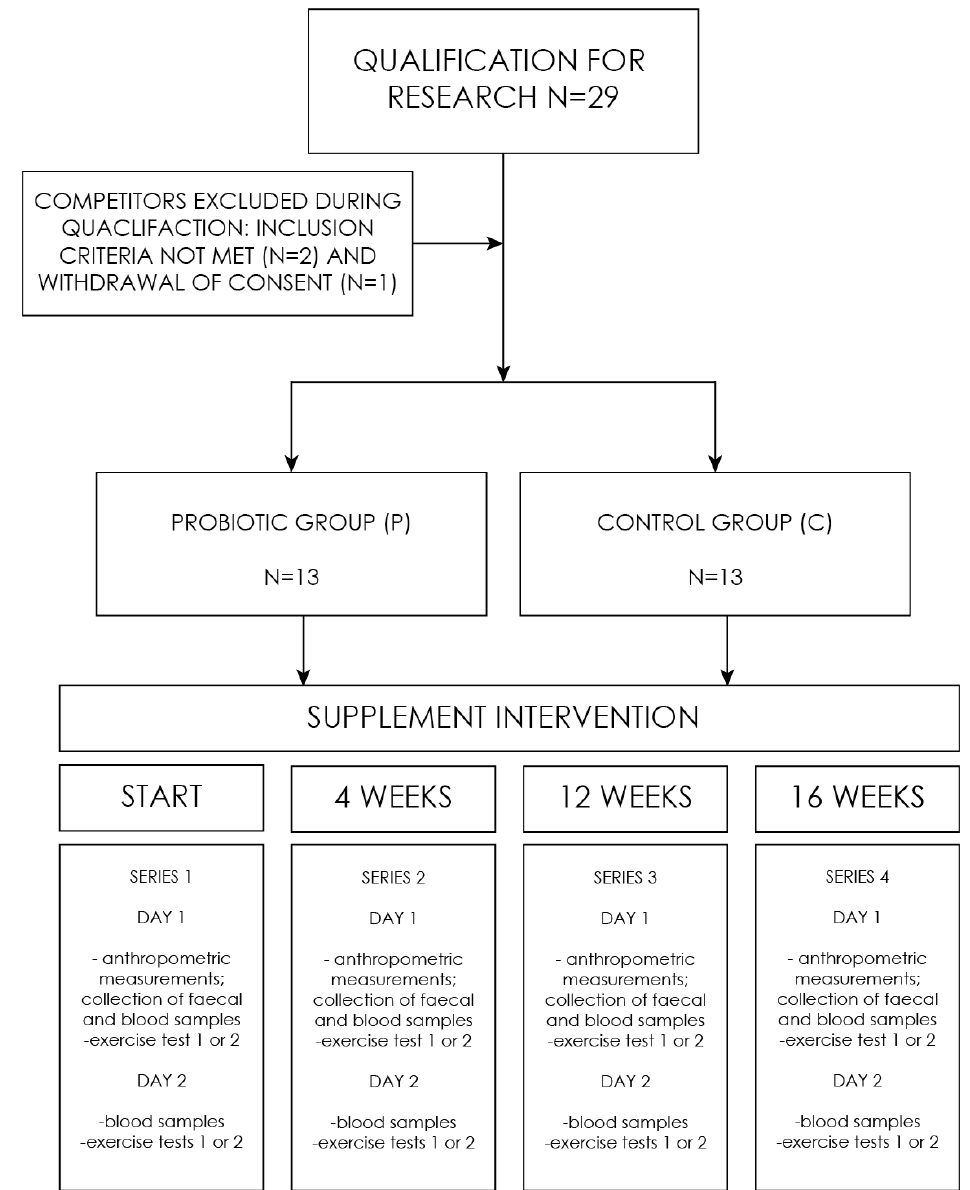
Figure 1. Research process flowchart.